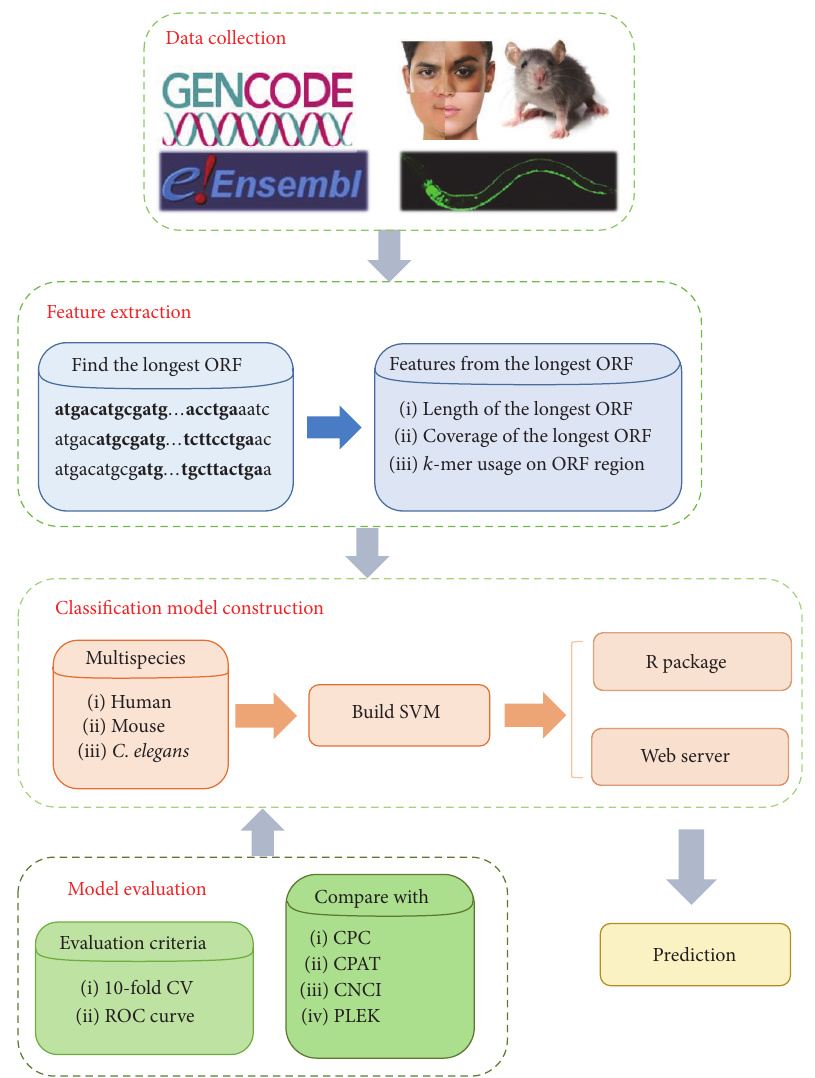
Figure 1: The framework of Lncident: containing data collection, feature extraction, classification model construction, and model